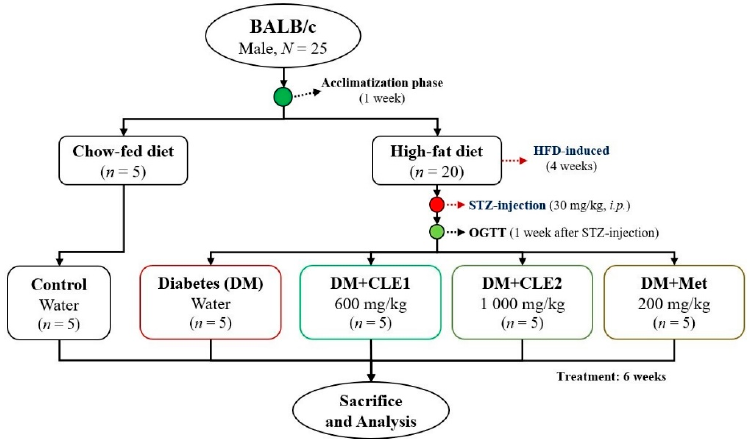
Figure 1. Flowchart showing the effects of Caulerpa lentillifera extract on diabetic male mice fed a high-fat diet with streptozotocin. CLE, Caulerpa lentillifera extract; HFD, high-fat diet; Met, metformin; OGTT, oral glucose tolerant test; STZ, streptozotocin.